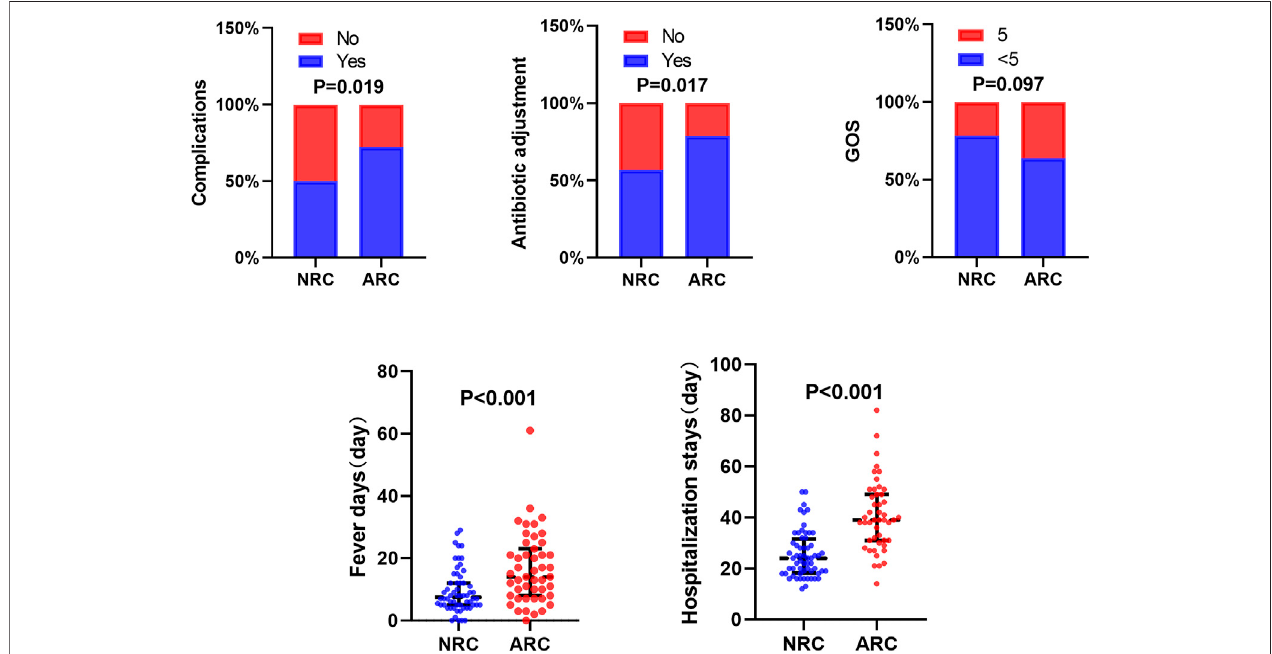
FIGURE 2 | Clinical ef fi cacy indicators in different eGFR